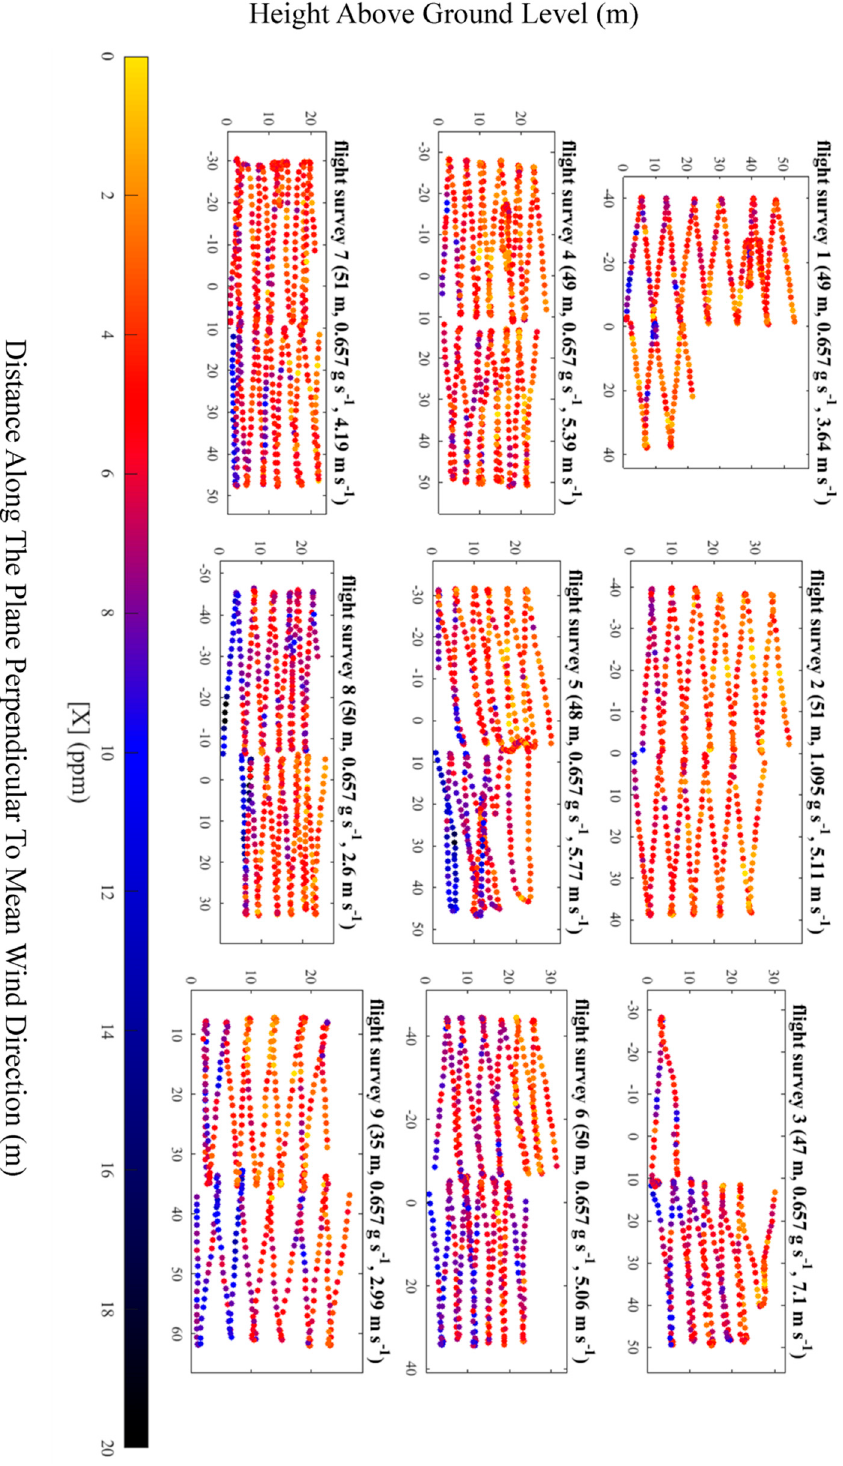
Figure 6. UAV flight tracks for each flight survey. The colour of each dot represents the magnitude of [ X ]. The parallel distance of the sampling plane from the emission source, the true emission flux and the average wind speed at 3.3 m (the height of the anemometer) are given in brackets. In order to calculate [ X ] the lowest [ X ] 0 measurement from flight survey was treated as the offset (see text). Flux quantification was attempted using the [ X ] measurements for each survey, presented in Figure 6, using the near ‐ field Gaussian plume inversion (NGI) technique, described by Shah et al. [33]. The NGI method models turbulent plumes sampled near to source, by assuming time ‐ averaged